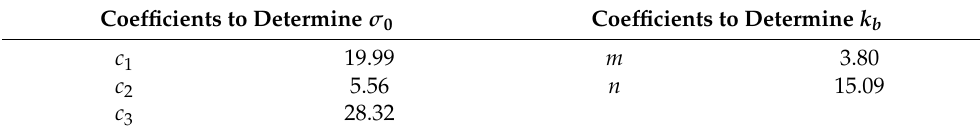
Table 5. Coefficients to calculate σ 0 and k b